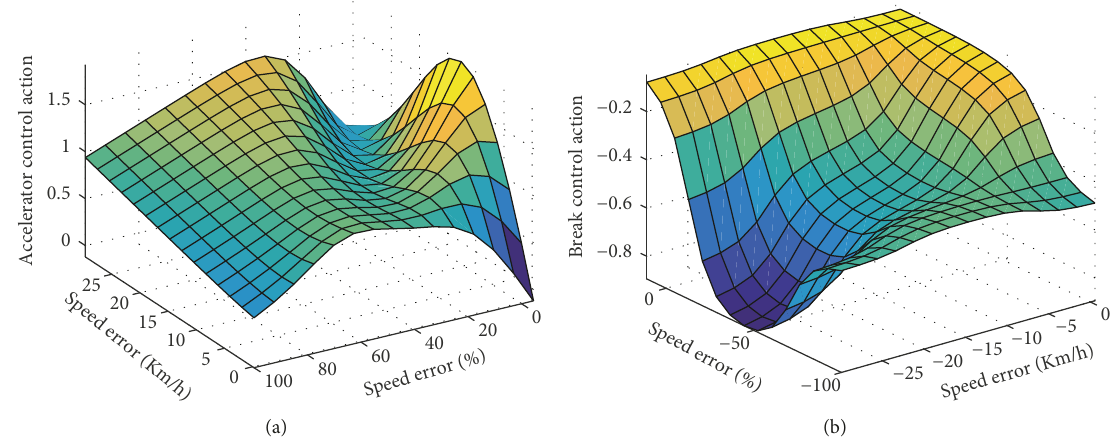
Figure 7: (a) Control surface of ANFIS for accelerator; (b) control surface of ANFIS for